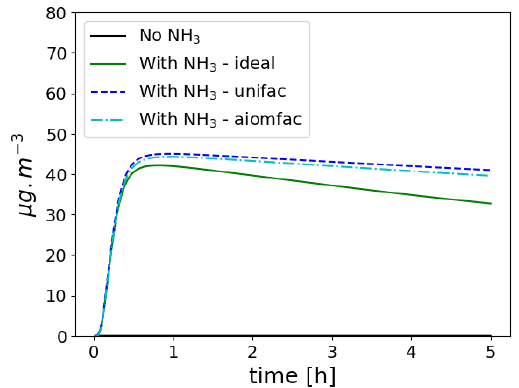
Figure 10. Time evolution of isoprene SOA in the particle